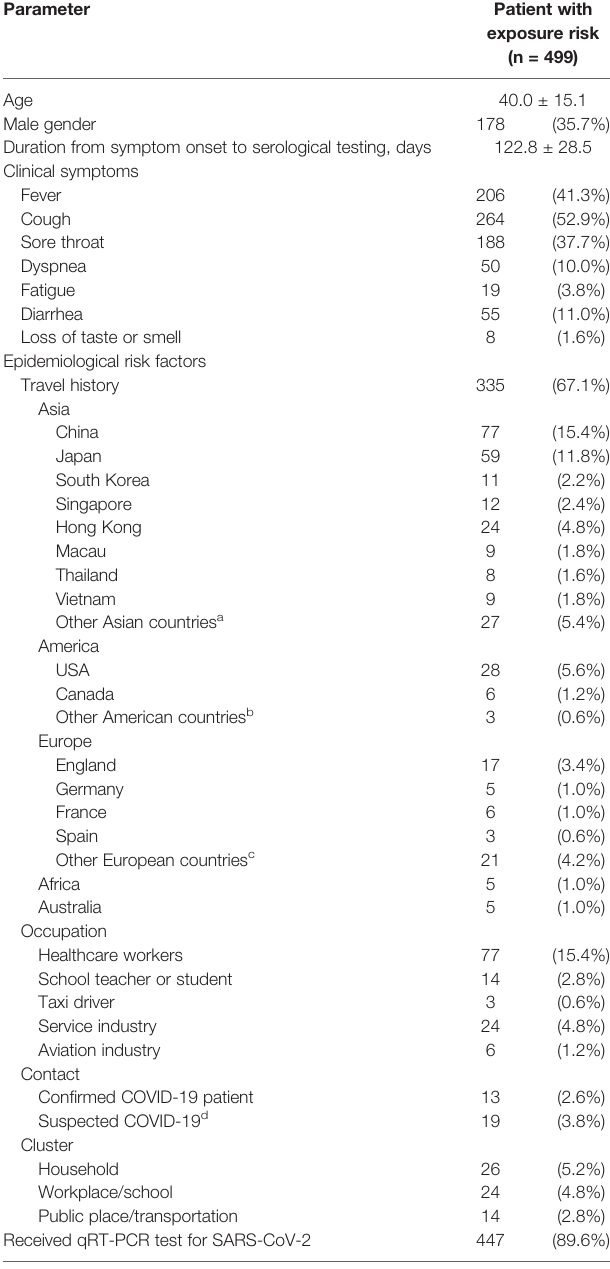
TABLE 1 | Clinical characteristics and epidemiological risk factors of contracting severe acute respiratory syndrome coronavirus 2 (SARS-CoV-2), of the 499 participants who visited the study hospital for coronavirus disease 2019 (COVID- 19)